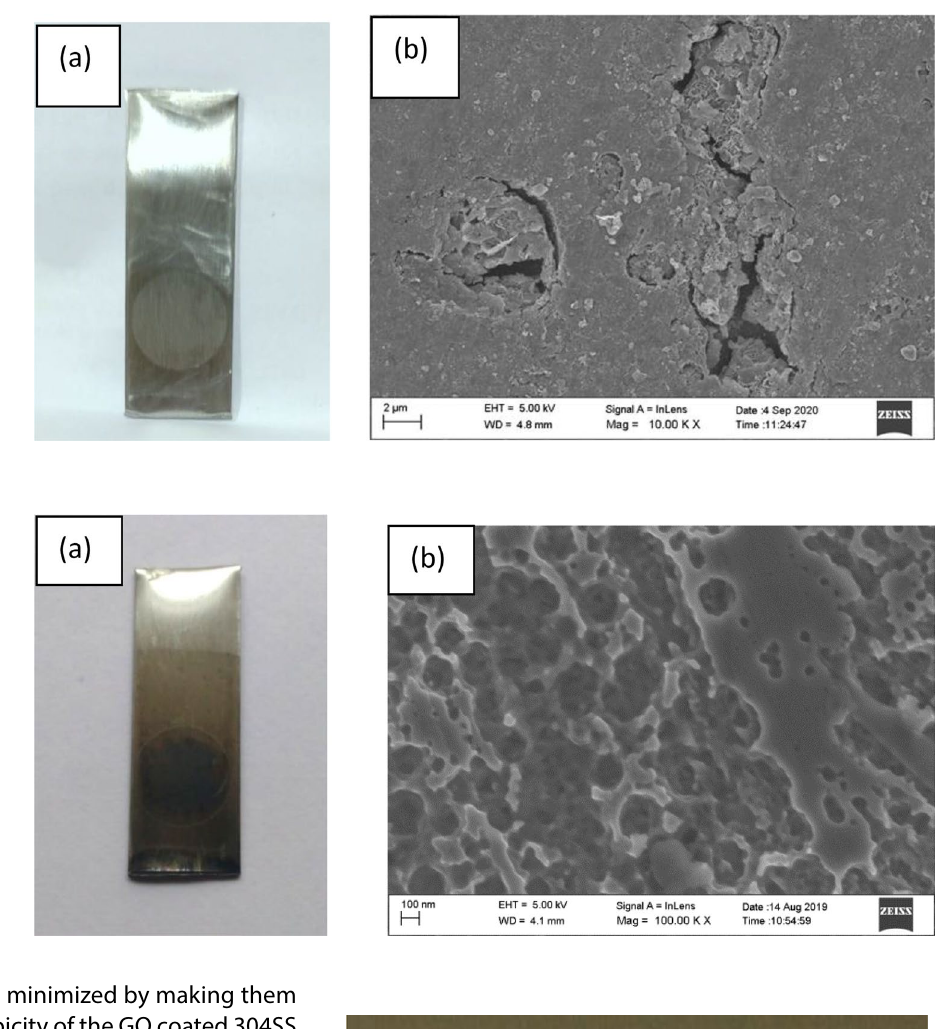
Fig. 4 a Photograph and b SEM micrograph bare 304SS after prolonged corrosion